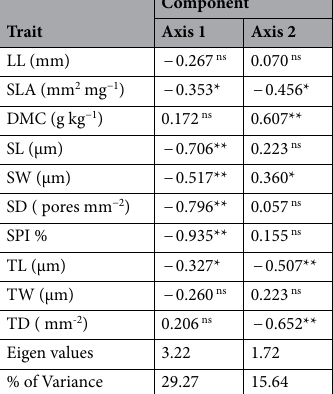
Table 3. Leaf functional traits in the principal component analyses (PCA) between three different climates. LL: Leaf length, DMC: dry matter content, SLA: specific leaf area, SL: stomata length, SW: stomata width, SD: stomatal density, SPI: stomatal pore index, TL: trichome length, TW: trichome width, TD: trichome density. * P < 0.05; ** P < 0.01.